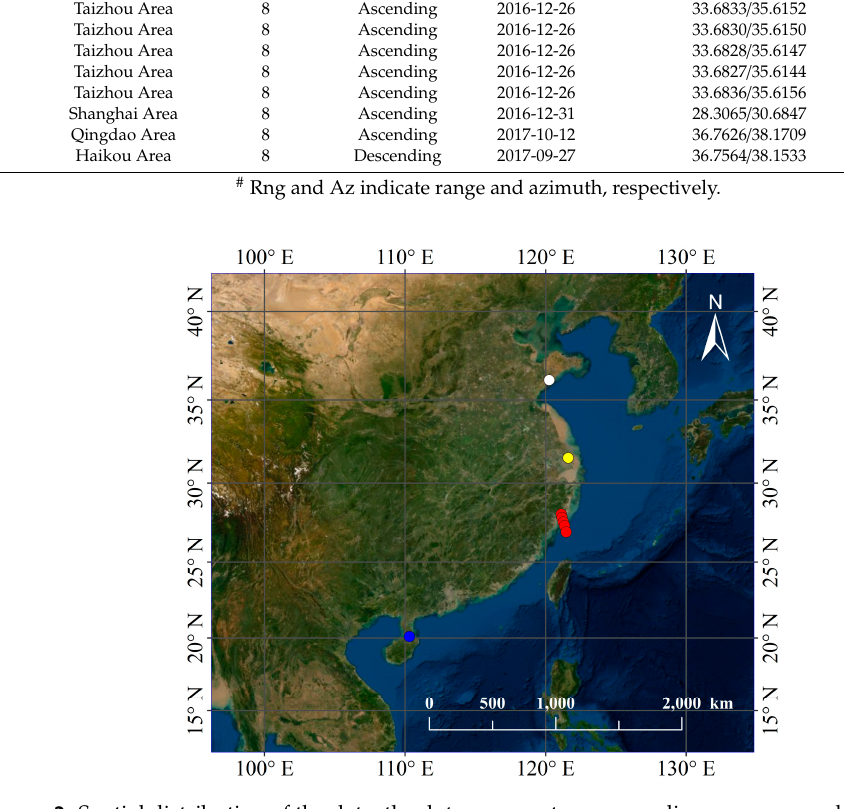
Figure 2. Spatial distribution of the data, the dots represent corresponding areas covered by the images we used. Respectively, the white dot represents the Qingdao area, the yellow dot denotes the Shanghai area, the red dots denote the Taizhou area, and the blue dot denotes the Haikou area. Table 2. The information about the Gaofen-3 images employed in the experiment.